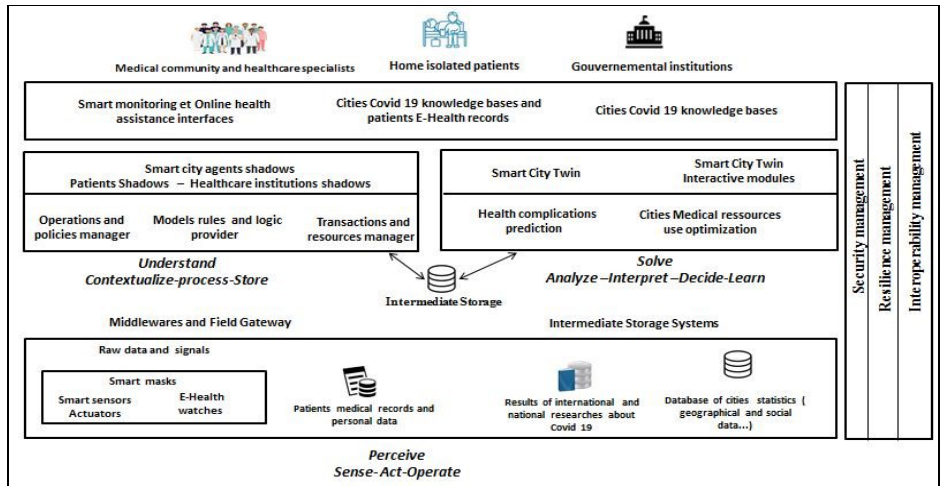
Figure 2. Smart city surrogate architecture for pandemic management